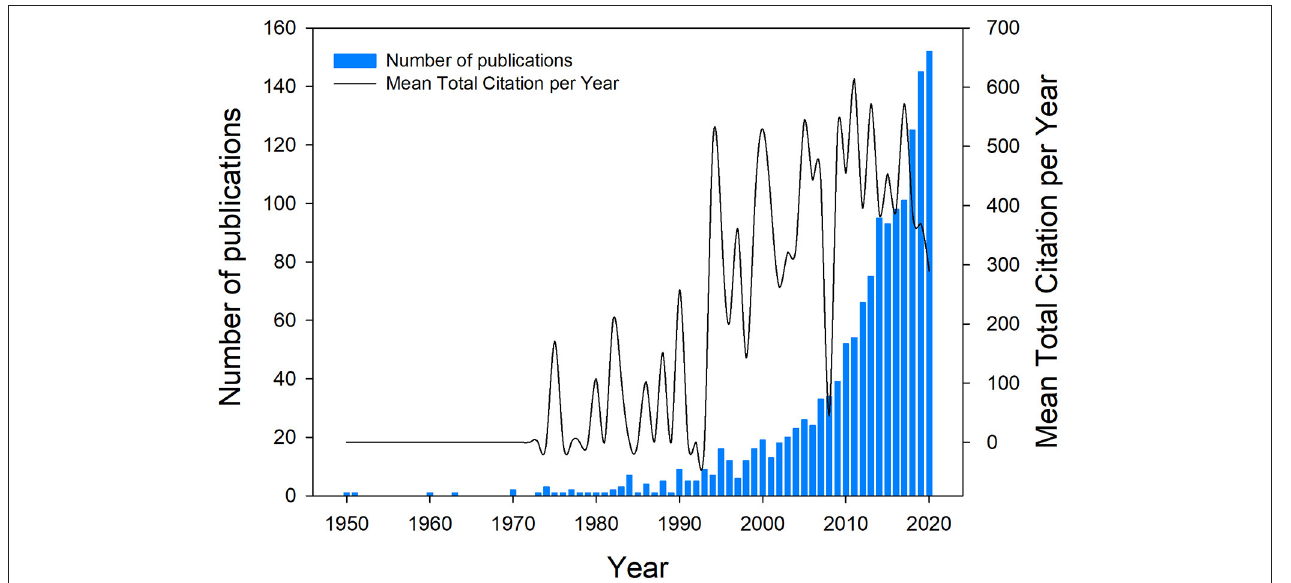
TABLE 1 | The 10 most-cited articles about microalga-fungi consortia. Title Source (Country) Year Citations Microbial carbonates: the geological record of calcified bacterial algal mats and biofilms 2 Effects of nitrogen sources on cell growth and lipid accumulation of green alga Neochloris oleoabundans